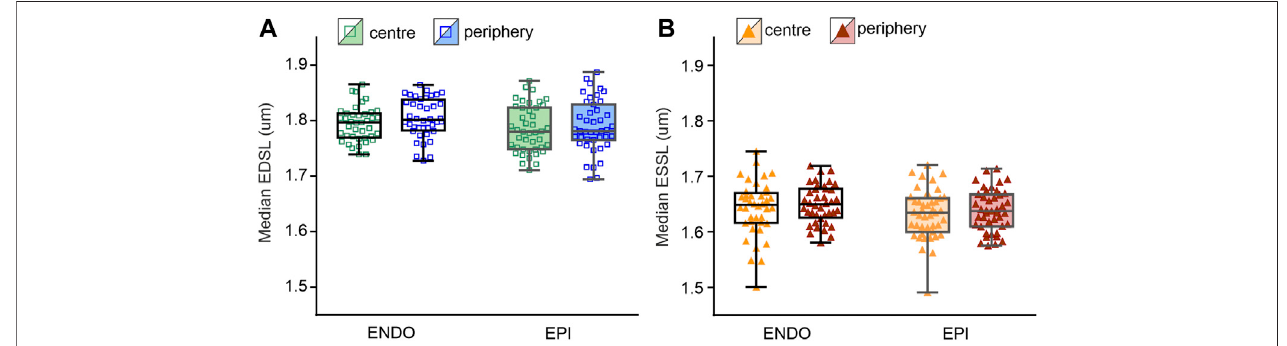
FIGURE 4 | Median SL values obtained from individual SL sets in central and peripheral regions of ENDO ( n = 40) and EPI ( n = 43) cardiomyocytes (from 8 hearts). (A) : Median end-diastolic SL (EDSL) values. (B) Median end-systolic SL (ESSL) values. Two-way ANOVA was used for all comparisons. None of the comparisons revealed any statistically signi fi cant differences.